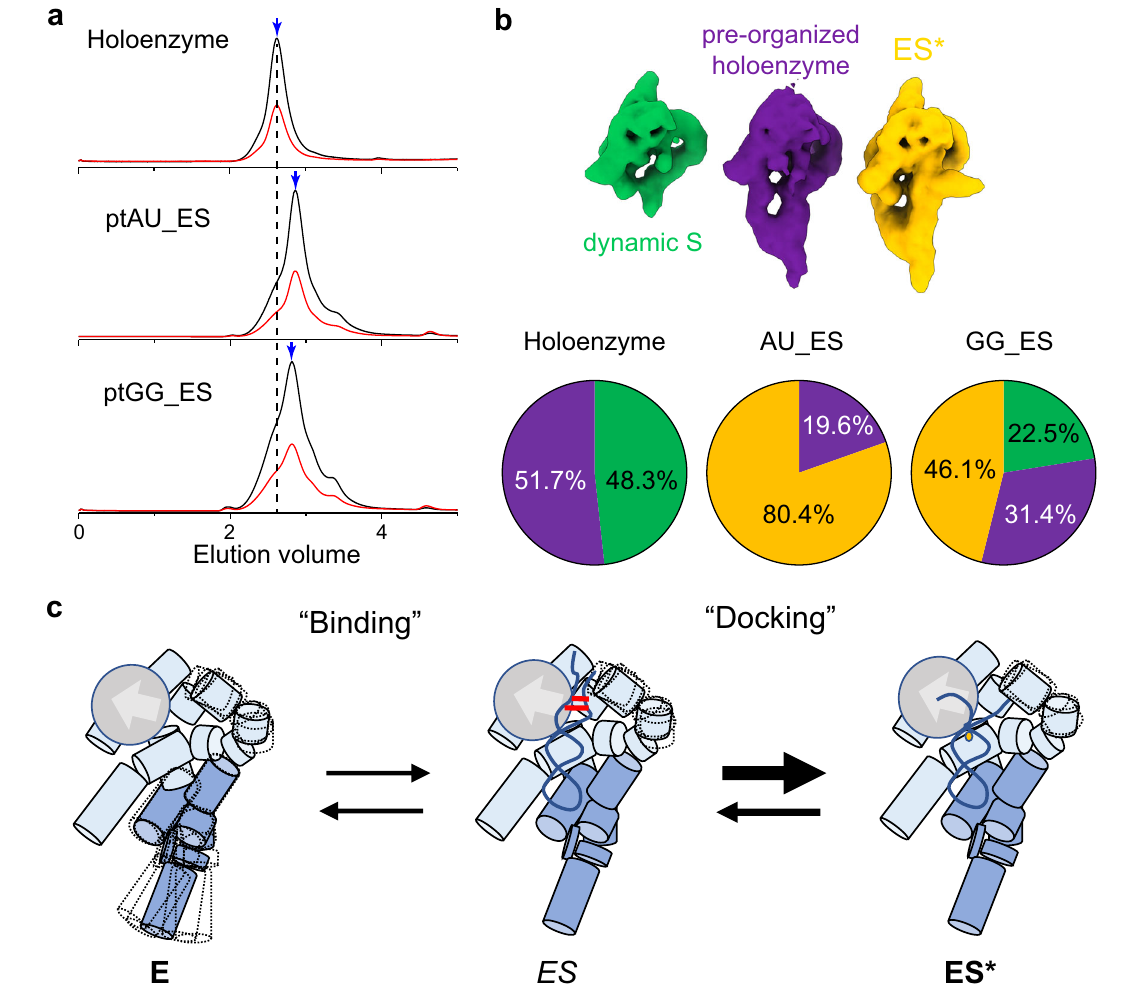
Fig.5|DynamicsoftheRNasePholoenzymeandEScomplex.a Foldingof E.coli RNase P holoenzyme and assembly with various ptRNA substrates. Size-exclusion chromatograms of RNase P holoenzyme in the presence of Mg 2+ (top) and AU_ES* and GG_ES* ptRNA-bound complexes assembled in the presence of Ca 2+ . UV absorbancepro fi